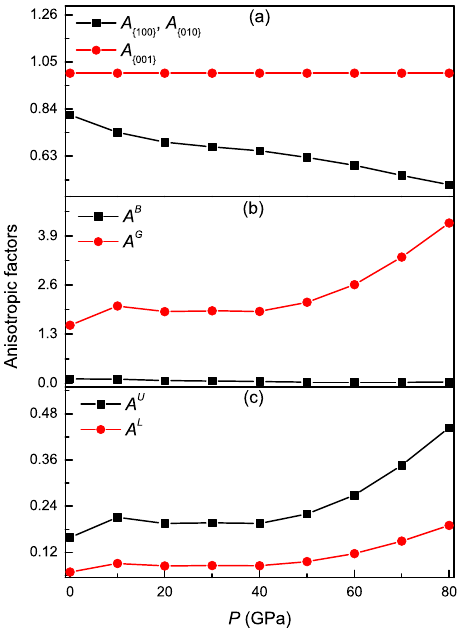
Figure 9. Shear anisotropic factors A { 100 } , A { 010 } , and A { 001 } ( a ), percentage anisotropy in compressibility A B and shear A G ( b ), the universal anisotropy index A U and the log-Euclidean anisotropy index A L ) ( c ) as a function of pressure for Ti 3